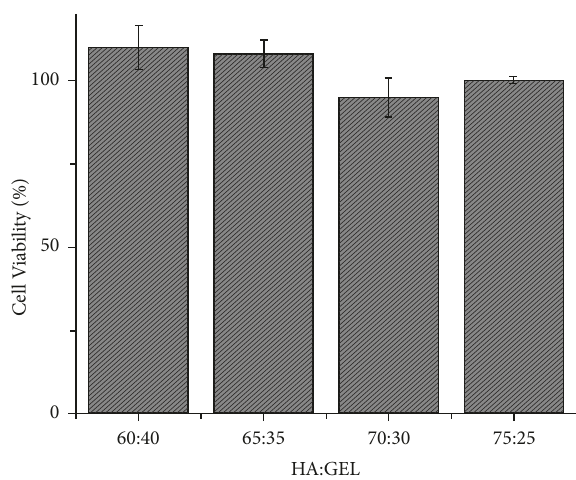
Figure 7: The cytotoxicity test result of the IBS sample with several HA:GEL ratios.